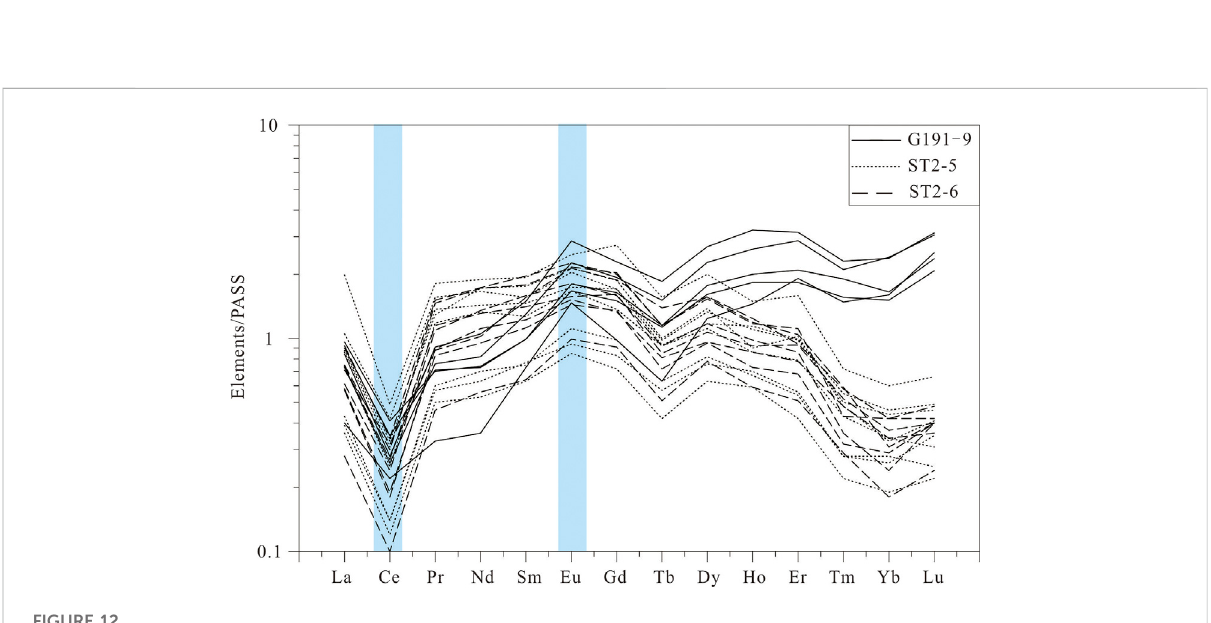
FIGURE 12 PAAS-normalized REE diagram for calcite in the P 3 w